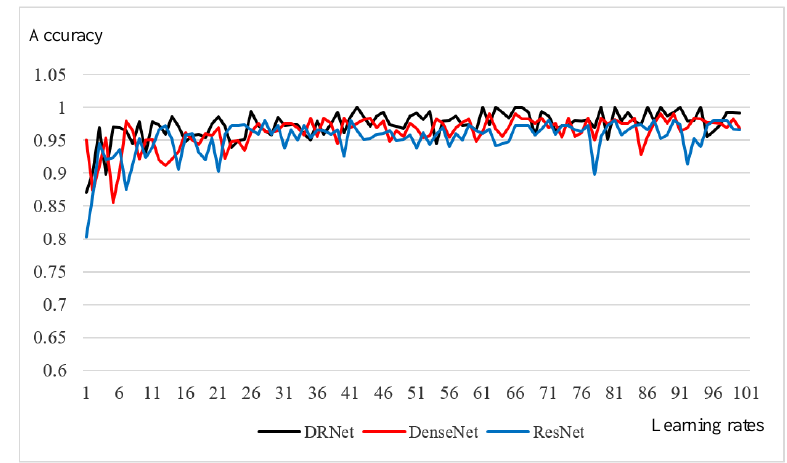
Figure 6. Accuracy curve of the networks.